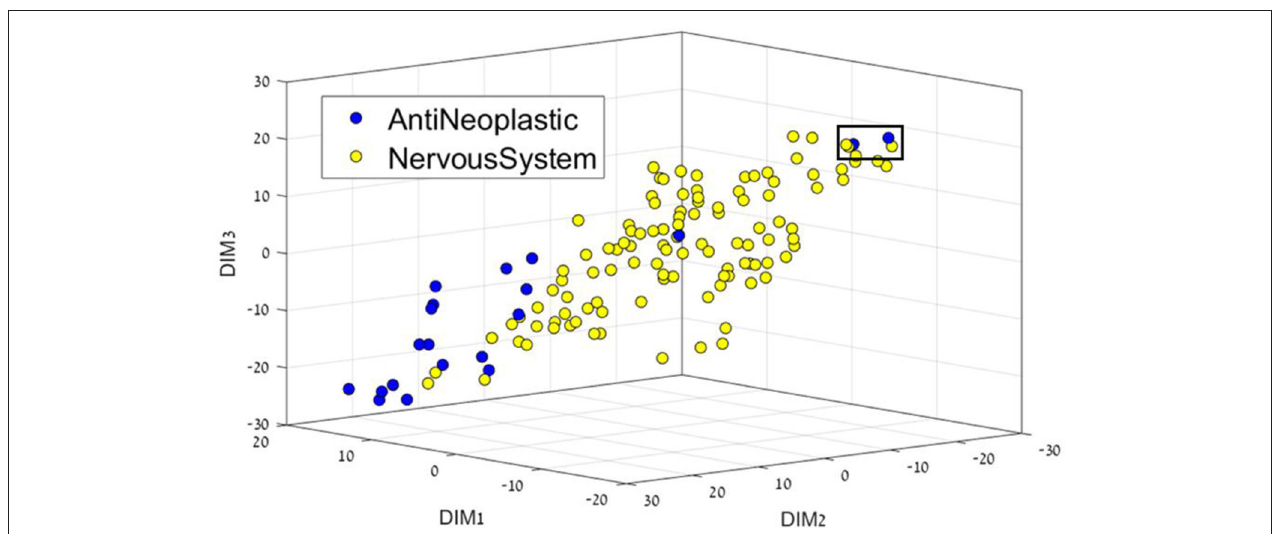
FIGURE 2 | 3D representation of the Anti-Neoplastic-Nervous system feature space using the t-SNE algorithm for dimension reduction. Two Anti-Neoplastic compounds (two blue dots in the black square) are markedly different from the rest of the Anti-neoplastic bulk. They correspond to compounds fluorouracil (5-FU), an atypically small compound – one ring –, and to pentostatin, also a small, polar compound; both of them acting as nucleoside analogs.